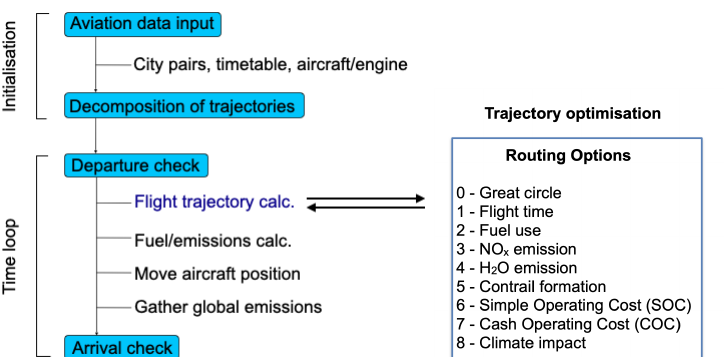
Figure 3. An overview of an AirTraf simulation, adapted from [43] and updated with the new optimisation objectives [33].